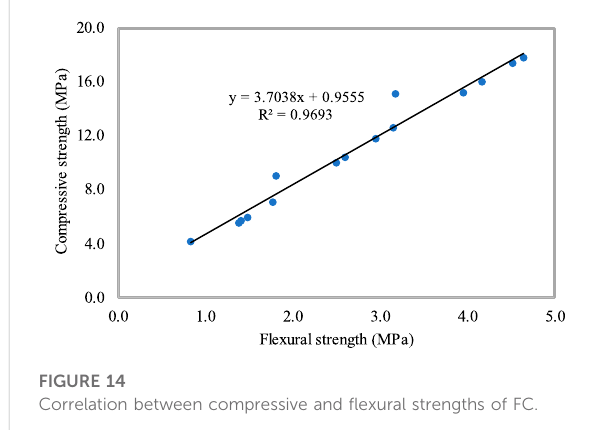
FIGURE 14 Correlation between compressive and fl exural strengths of FC.